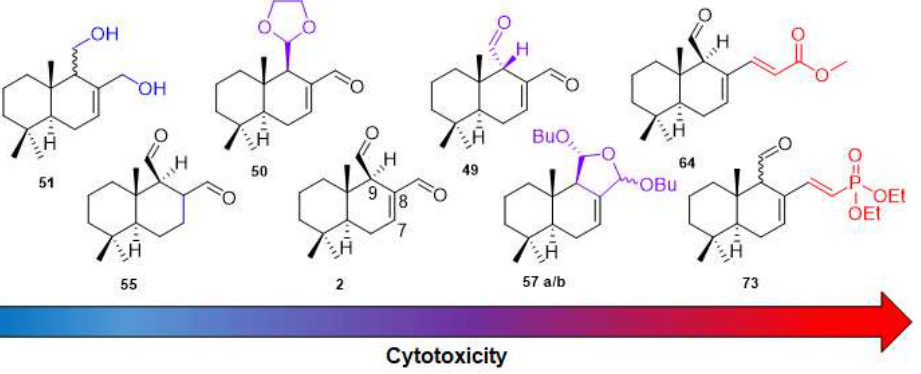
Figure 16. General trends in cytotoxicity for semi-synthetic derivatives from polygodial ( 2 ). Derivati- zations leading to an increase in cytotoxicity are depicted in red and functional groups, leading to a decrease are shown in blue. Other functionalizations with a minor/moderate impact on cytotoxic activity are depicted in purple.